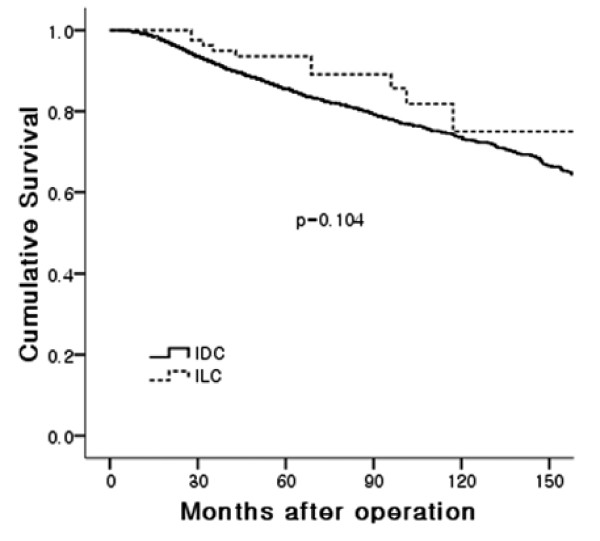
Overall survival.